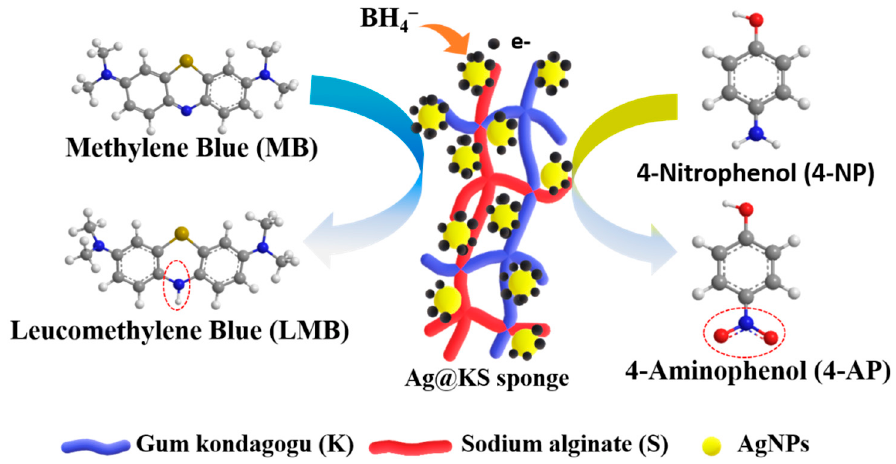
Figure 7. Proposed catalytic reduction mechanism of MB and 4-NP in the Ag@KS sponge network, using NaBH 4 .